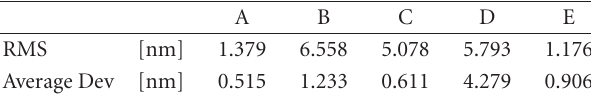
Table 1: Mean measurements of surface roughness estimated by AFM, Random Mean Square (RMS), and Average Deviation (Aver- age Dev); glass coated with nonhexylated polymer (A), glass coated with hexylated polymer (B), glass coated with hexylated polymer and spin coated with amorphous silicon dioxide (C), glass coated with hexylated polymer and spin coated with nanoporous silicon dioxide (D), and untreated glass